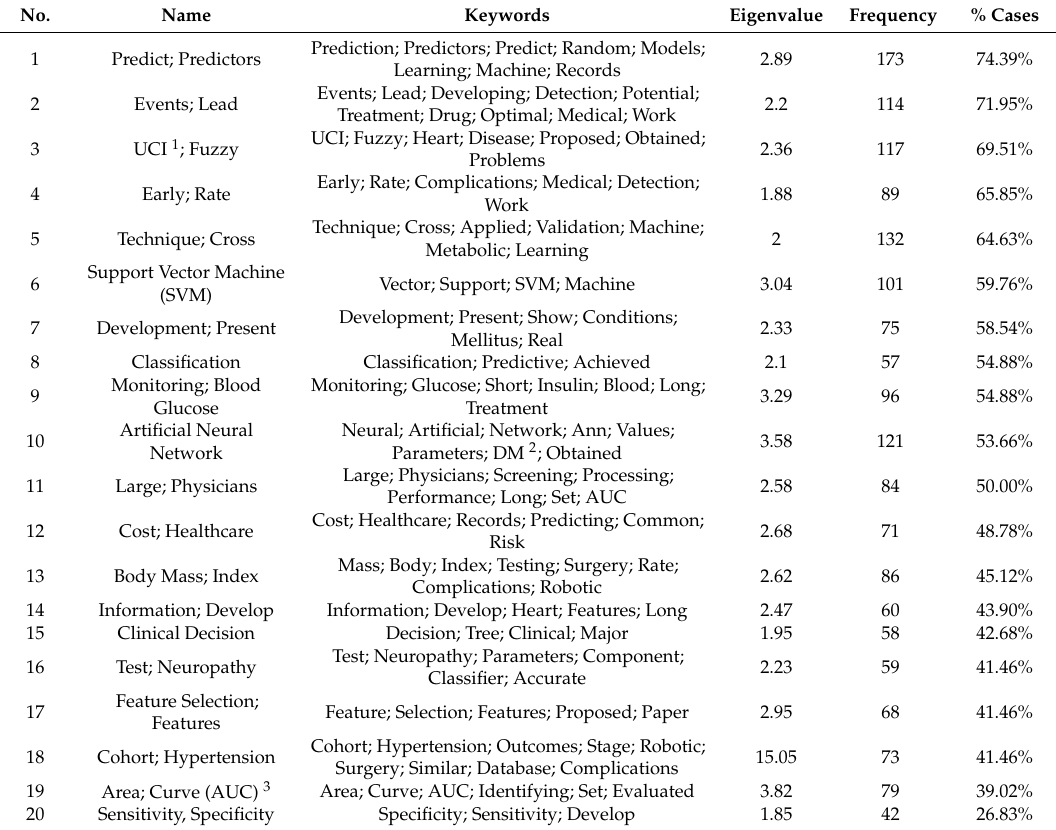
Table 4. Top 20 research domains emerged from exploratory factor analysis of all abstracts’ contents.